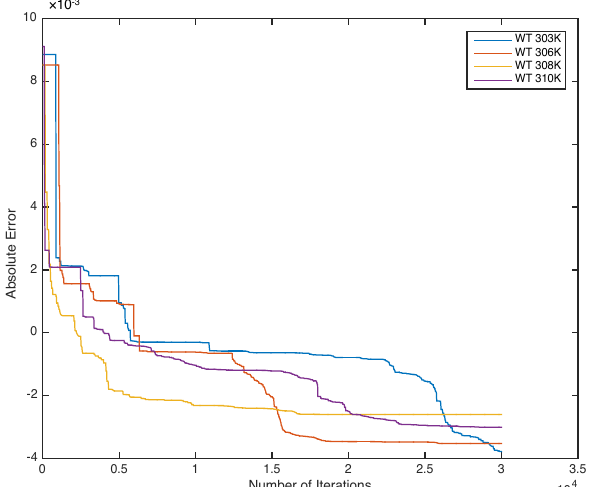
Figure 4. The minimization of overall absolute error with the number of epochs. Results under different temperatures are represented by different thin colored lines (as indicated in the legend of the figure), the progression to final convergence of total error are observed in the figure.